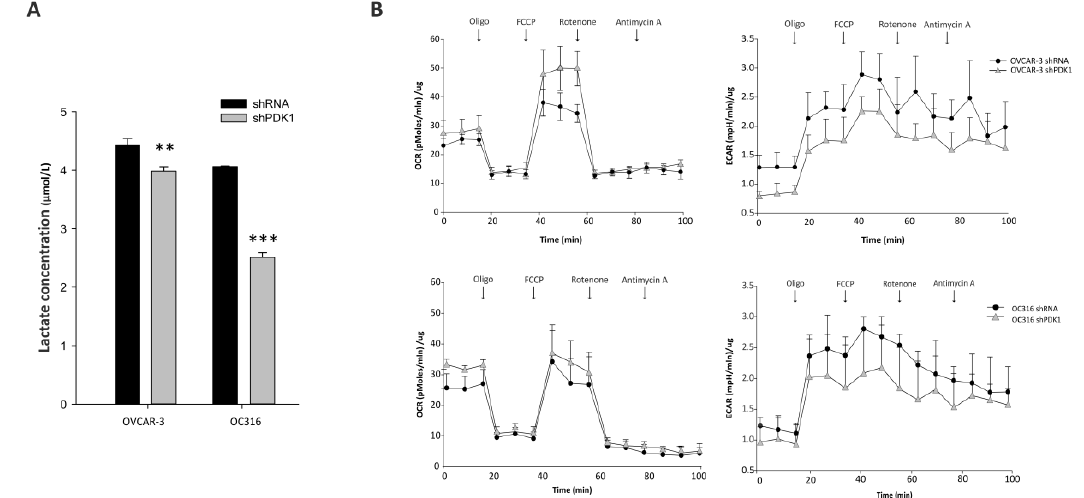
Figure 2. Effects of PDK1 silencing on glycolysis and cell metabolism. ( A ) Measurement of lactic acid production by PDK1-silenced and control cells, normalized by total protein content, ** p < 0.01, *** p < 0.001, t test. ( B ) Representative Oxygen consumption rate (OCR) and extracellular acidification rate (ECAR) traces obtained from shPDK1 and control cells. Serial additions of the ATP synthase inhibitor oligomycin, of the uncoupler FCCP, of the ETC complex I inhibitor rotenone, and of the respiratory complex III inhibitor antimycin A were carried out. Data are mean ± SD values of three replicates normalized to protein